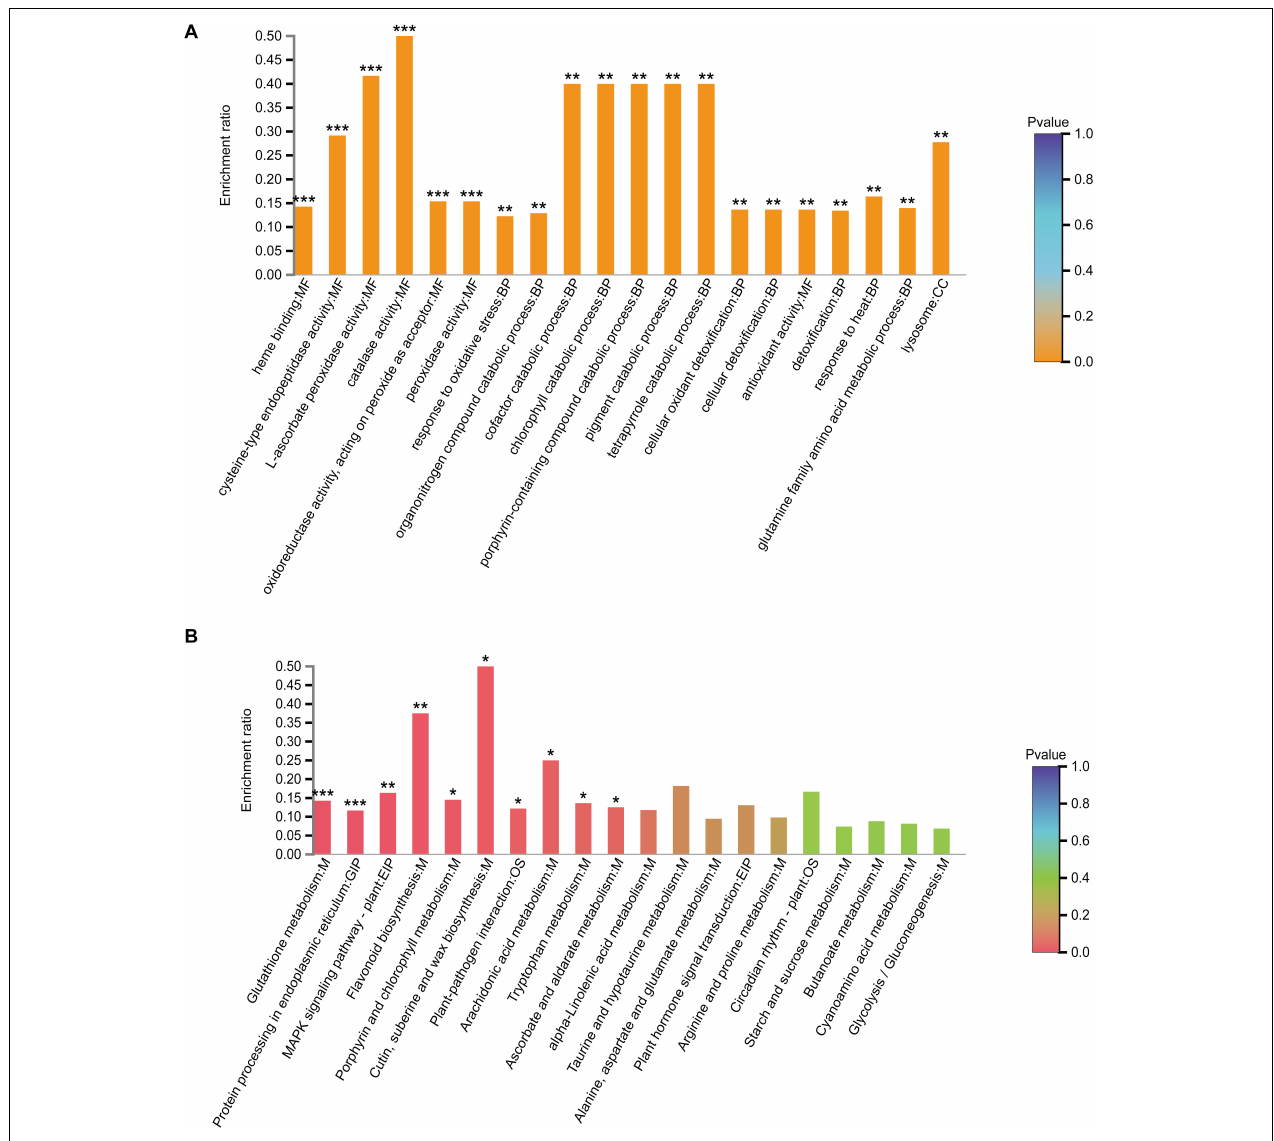
FIGURE 3 | (A) GO and (B) KEGG analysis of differentially expressed proteins in leaves at CK vs. AS. CK, control; AS, alkali stress (35 mmol.L − 1 Na 2 CO 3 :NaHCO 3 = 1:1). The color gradient indicated significance, *** indicated P < 0.001, ** indicated P < 0.01, * indicated P < 0.05.